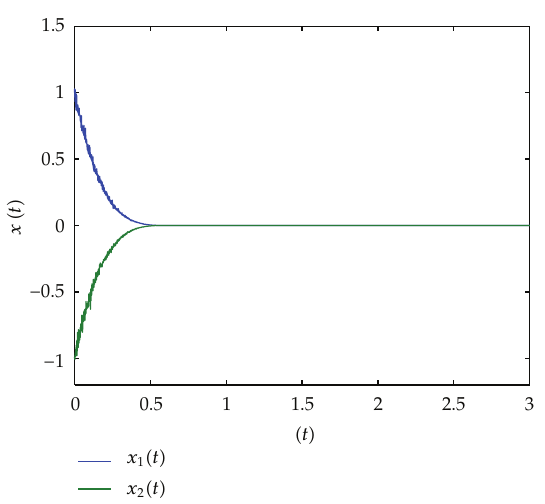
Figure 3: Trajectories of SNN (cid:2) 4.1 (cid:3) under the controller (cid:2) 4.3 (cid:3) with k 2 (cid:8) 1 . 5 in Example